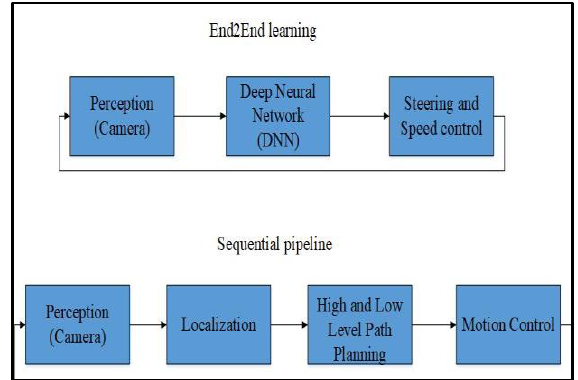
Fig. 1. Deep Learning-based self-driving